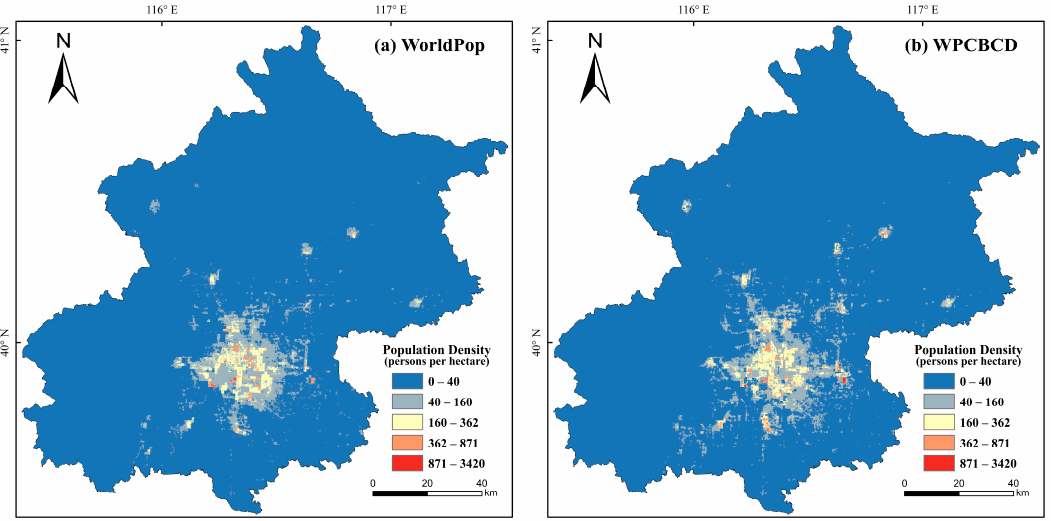
Figure 8. ( a ) WorldPop mainland China dataset in 2020. ( b ) WorldPop mainland China dataset corrected by census data in 2020. WPCBCD: WorldPop corrected by census